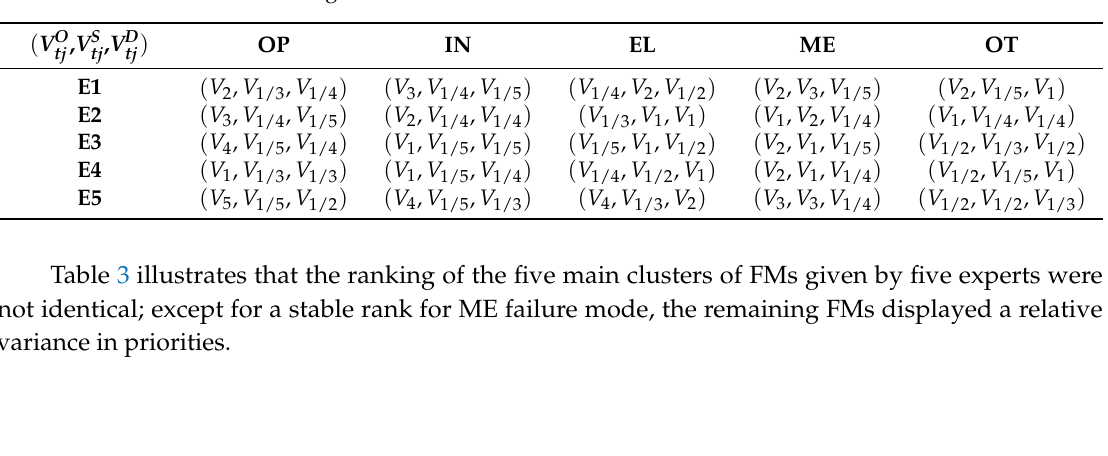
Table 2. Linguistic assessment values for the cluster of failure